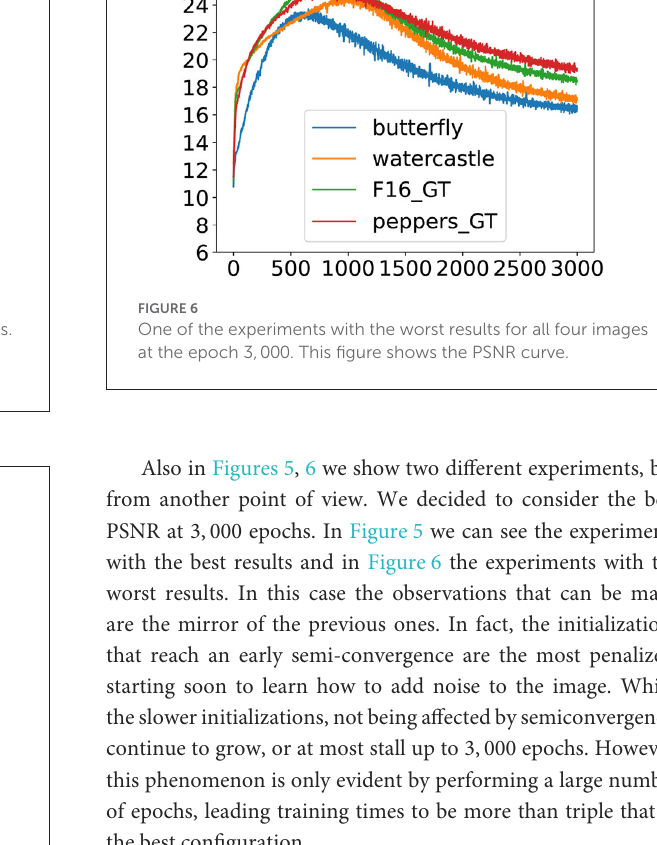
FIGURE4 One of the experiments with the worst results for all four images. This figure shows the PSNR curve.